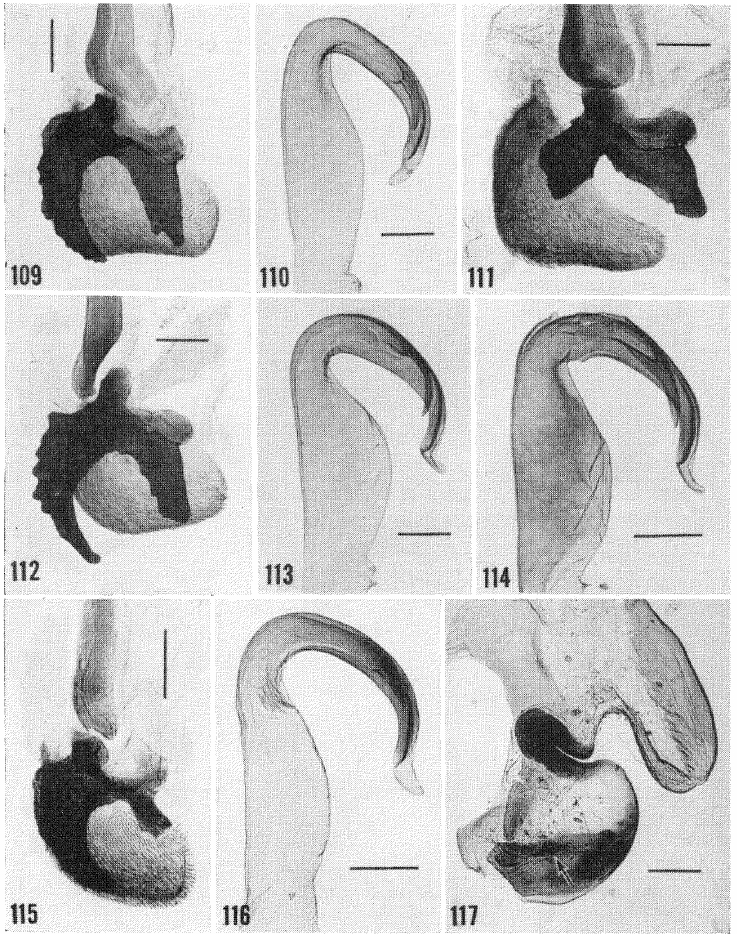
Figs. 109-117. Cockroach male genitalia. 109-113. Elilamlra jorgenseni. 109-110. (94 ANSP). Paratype o Elilamlra stigmatiIhora Rehn (--- E. jor- genseni). Misiones, Argentina. 111. (95 ANSP). Misiones, Argentina (det. Rehn). 112-113. (81 ANSP). same data as figs. 109-110. 114-117. Elilamlra --- berlandi. 114. (47 ANSP). Provincia Sara, Bolivia (det. Hebard). 115- 117. (83 ANSP). Paratype. Ieafio, Santiago del Estero, Argentina. (arrow in 117 indicates setal brush). (scale 0.2